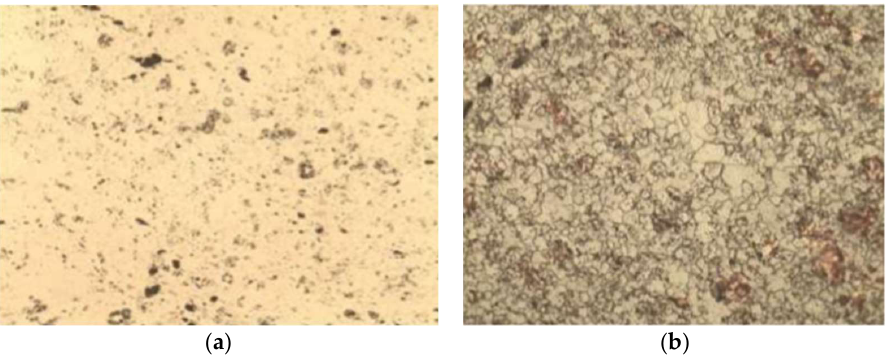
Figure 6. Photos of microstructure of pellet sintered in vertical position (1600 °С, 120 min), at different magnifications: ( a ) grain, lower part of the pellet, 500×; ( b ) grain, upper part of the pellet, 500×; ( c ) thin section after etching, 25×; ( d ) delamination, 100×.